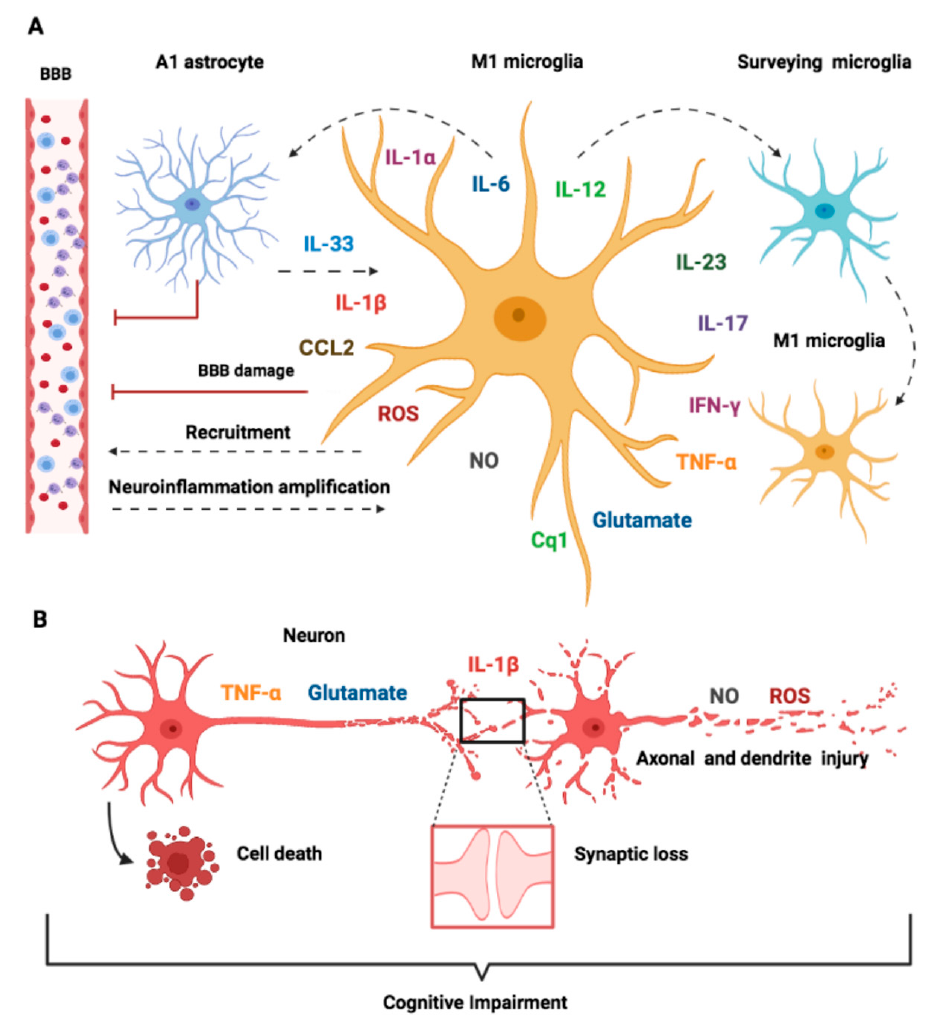
Figure 3. Schematic representation of molecular mechanisms of microglia-mediated neurotoxicity. Classically (M1) activated microglia induce neurotoxicity by direct and indirect mechanisms, including the induction of neurotoxic astrocytes (A1), damage of the brain endothelium, promotion and intensification of inflammation, synaptic dysfunction, neuronal injury, and cell death. All these mechanisms contribute to cognitive impairments and acute neurological dysfunctions in SAE. ( A ) M1 microglia produce pro-inflammatory molecules such as IL-1 β , IL-1 α , IL-6, IL-12, IL-23, IL-17, IFN- γ , TNF- α , glutamate, C1q, NO, and ROS. The secretion of IL-1 α , TNF- α , and C1q by M1 microglia induces A1-polarized astrocytes and contributes to BBB disruption and IL-33 release, enhancing the inflammatory response of activated microglia. The release of ROS, NO, and CCL2 increases the brain endothelium’s permeability and mediates BBB disruption. The generation of IL-1 β , IL-12, IL-23, IL-17, IFN- γ , TNF- α , and glutamate can, in turn, activate surveying microglia and recruit immune cells from the periphery to the CNS, which amplifies the inflammatory signal, creating a vicious circle of sustained and amplified neuroinflammation. ( B ) M1 microglia effects on neuronal functions. The release of TNF- α and high levels of glutamate induce neuronal excitotoxicity and cell death. IL-1 β release by activated microglia causes synaptic loss. ROS and NO promote peroxidation of membrane lipids and axonal damage. BBB, blood–brain barrier; IL, interleukin; C1q, complement component 1; NO, nitric oxide; ROS, reactive oxygen species; TNF, tumor necrosis factor; IFN, interferon. IL-33 is a cytokine released in the brain by astrocytes and oligodendrocytes. Cao et al. [119] demonstrated an increase in IL-33 mRNA and protein levels produced by astrocytes after intracerebroventricular injection of LPS. IL-33 derived from astrocytes enhances microglia’s inflammatory response to LPS and mediates cerebral endothelial activation and subsequent leukocyte recruitment. IL-33 knockout mice had reduced leukocyte